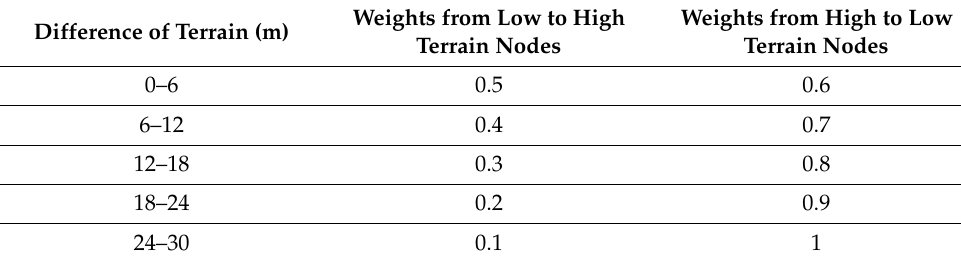
Figure 5. ( a ) Node degree graph. ( b ) Node strength graph. Table 1. Relationship between elevation and edge weight.